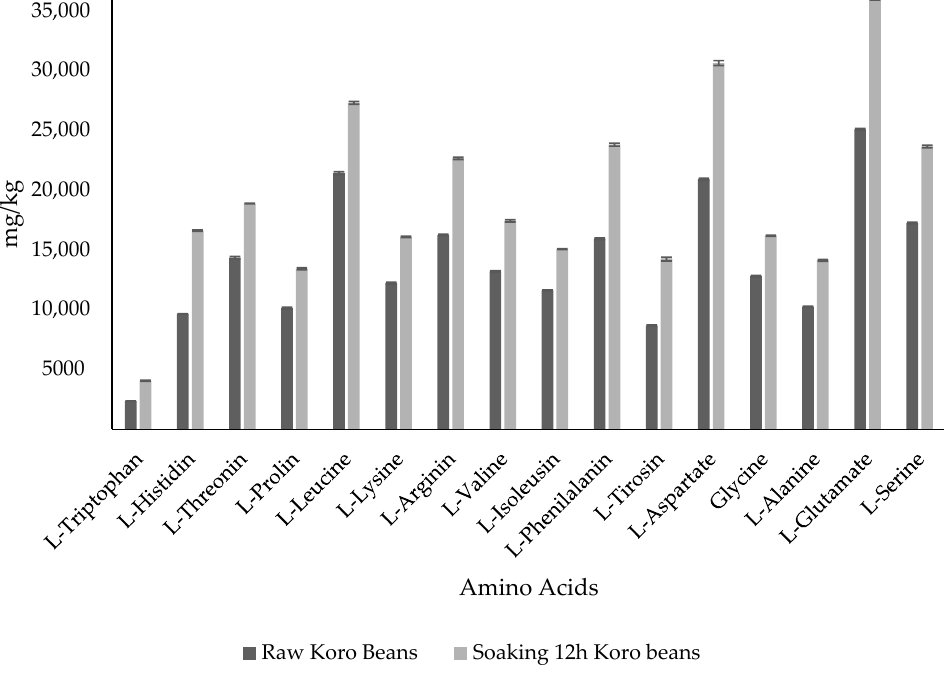
Figure 2. Amino acid content in raw Jack beans and 12 h soaking Jack beans.